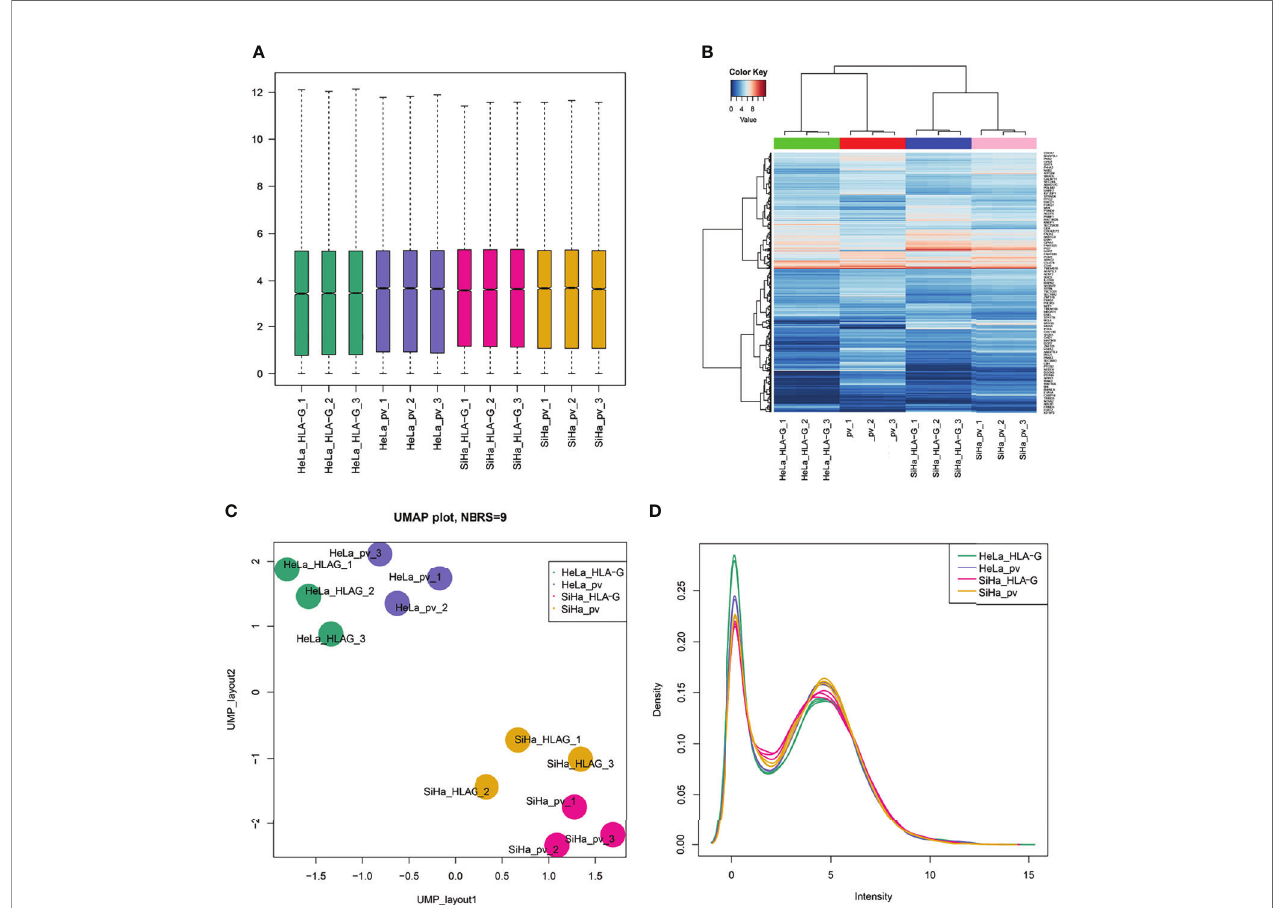
FIGURE 2 | Read quality statistics after fi ltering by RNA-seq analysis. (A) The gene expression normalization of SiHa-pVITRO2-mcs, SiHa-HLA-G-pVITRO2-mcs, HeLa- pVITRO2-mcs and HeLa-HLA-G-pVITRO2-mcs cells after being sequenced by the BGISEQ-500 platform and quanti fi ed by the RSEM software package. (B) Heatmaps draw by “ pheatmap ” of 1083 genes that signi fi cantly co-expressed with HLA-G in SiHa and HeLa cells. (C) UMAP plotting of SiHa-pVITRO2-mcs, SiHa-HLA-G-pVITRO2- mcs, HeLa-pVITRO2-mcs and HeLa-HLA-G-pVITRO2-mcs cells with 1083 genes that signi fi cantly co-expressed with HLA-G. (D) The expression values density of SiHa- pVITRO2-mcs, SiHa-HLA-G-pVITRO2-mcs, HeLa-pVITRO2-mcs and HeLa-HLA-G-pVITRO2-mcs by “ plotDensities ” function in “ limma ”